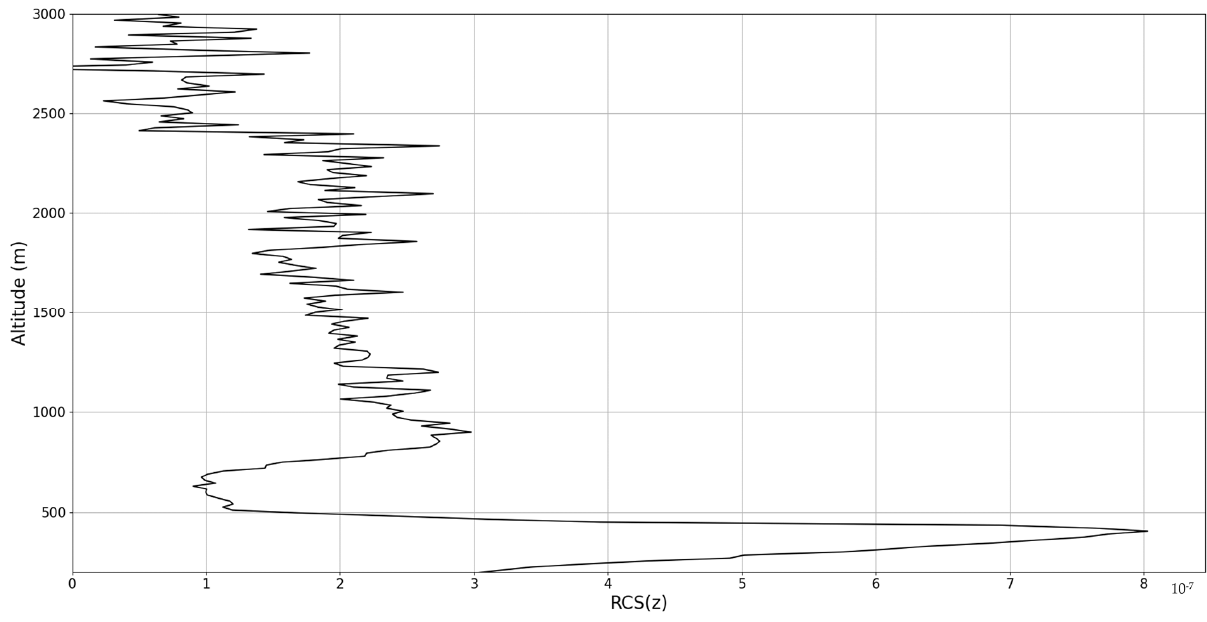
Figure 10. Zoomed-in RCS profile, λ = 1064 nm , Gala ț i, Romania, 22 December 2021. The coefficient C 2 (m − 2 3 ) is commonly used as an indicator of atmospheric turbu- lence strength; it can be also used to more accurately quantify the PBL altitude, and to